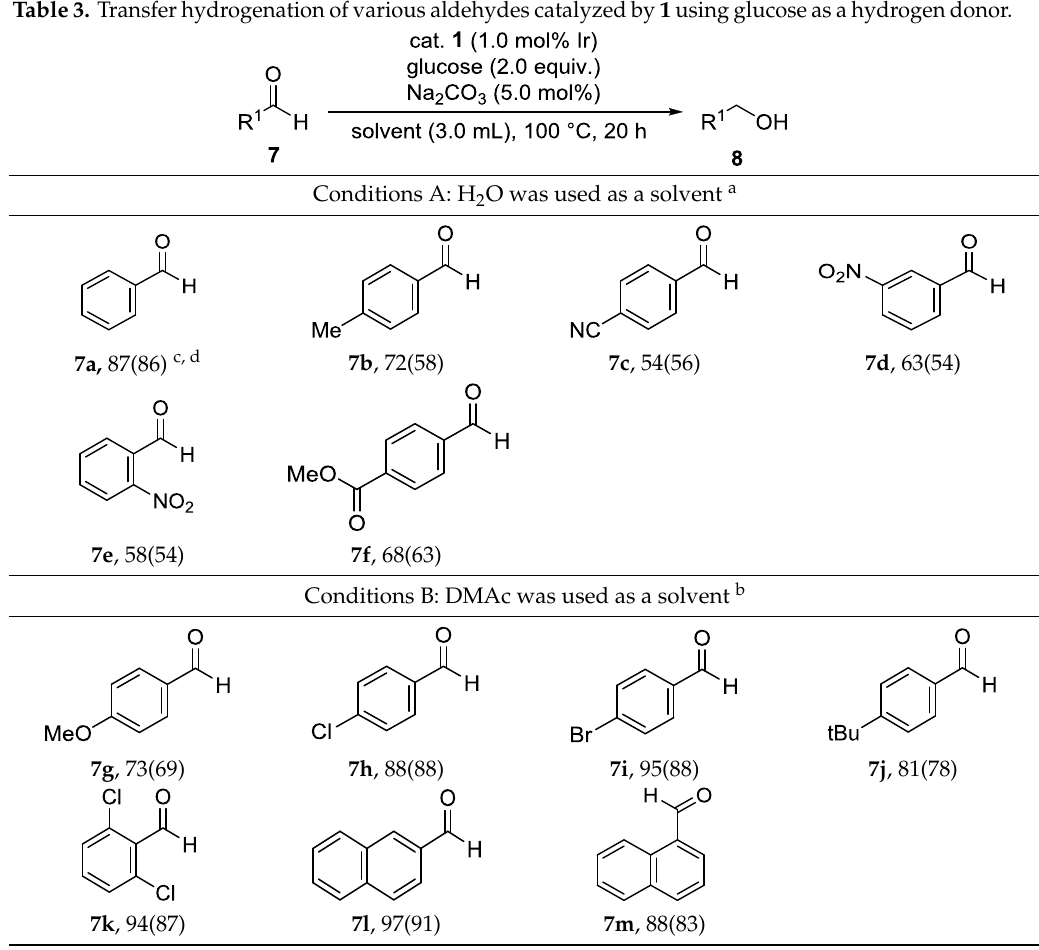
Table 3. Transfer hydrogenation of various aldehydes catalyzed by 1 using glucose as a hydrogen donor.